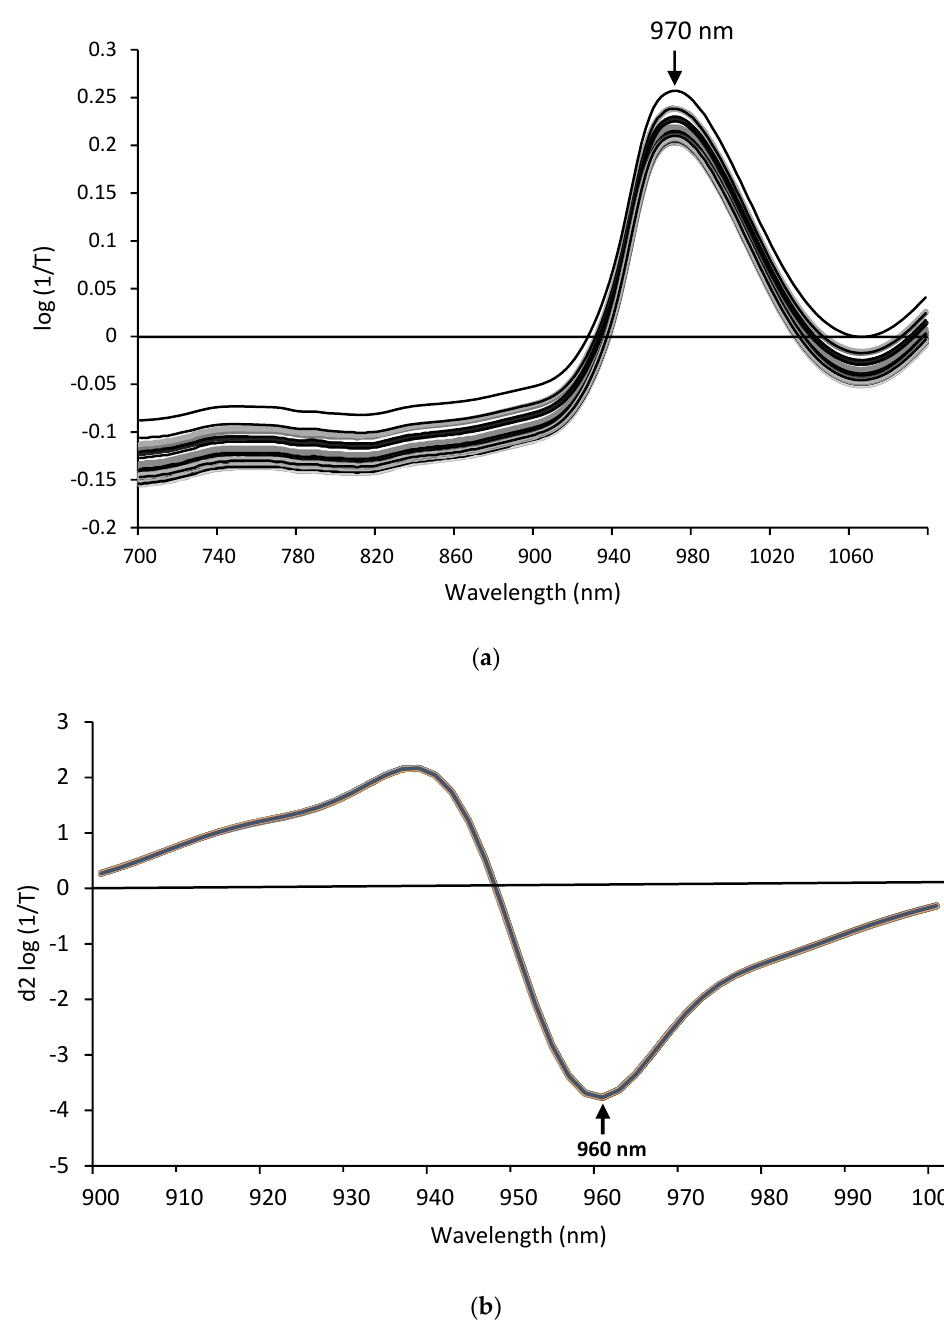
Figure 5b. To perform the discriminant analyses, 17 variables from d 2 log (1/T) value at 900 nm to that at 996 nm were used.